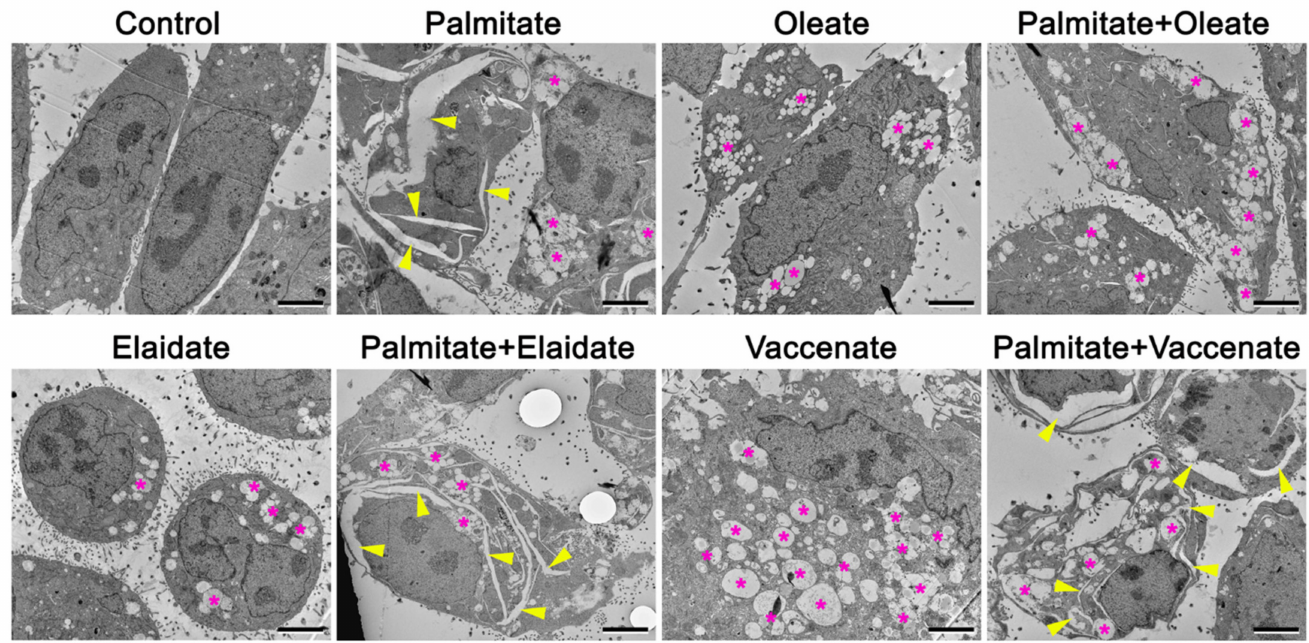
Figure 10. Electron micrographs of fatty acid treated cells. Cells were treated with BSA-conjugated palmitate, oleate, elaidate or vaccenate (800 µ M) or with palmitate (800 µ M) and oleate, elaidate or vaccenate at a 2:1 molar ratio (400 µ M) at 70–80% confluence for 8 h. Yellow arrowheads point to cracks along ER cisterns, magenta asterisks label groups of lipid vesicles. Scale bar 2 µ